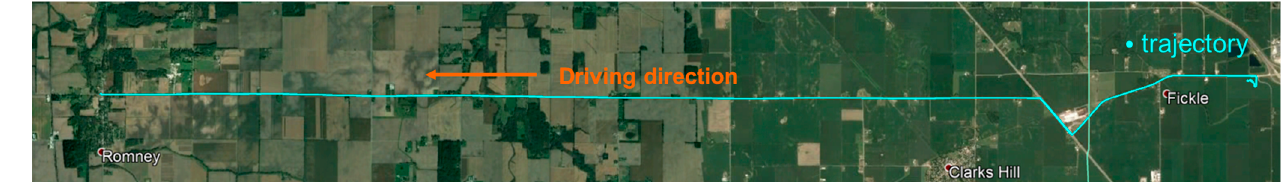
Figure 7. Location and trajectory of independent dataset.